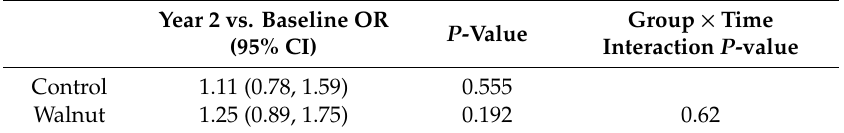
Table 4. Marginal logistic model using generalized estimating equations (GEE) for